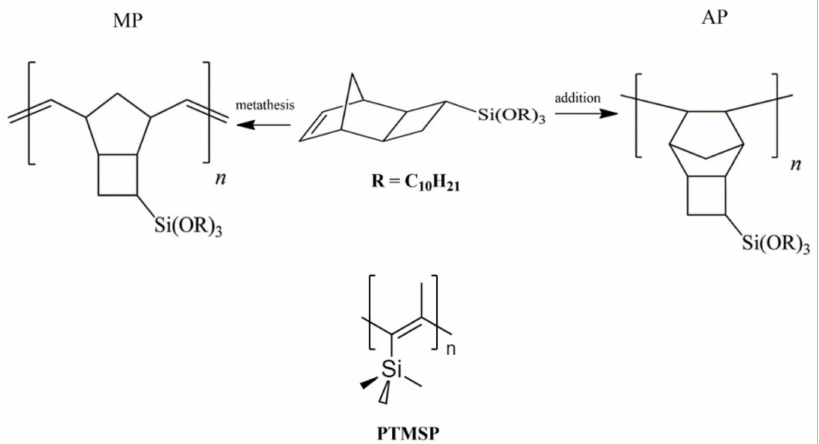
Figure 1. Structures of the investigated polymers together with the routes of polymerization of